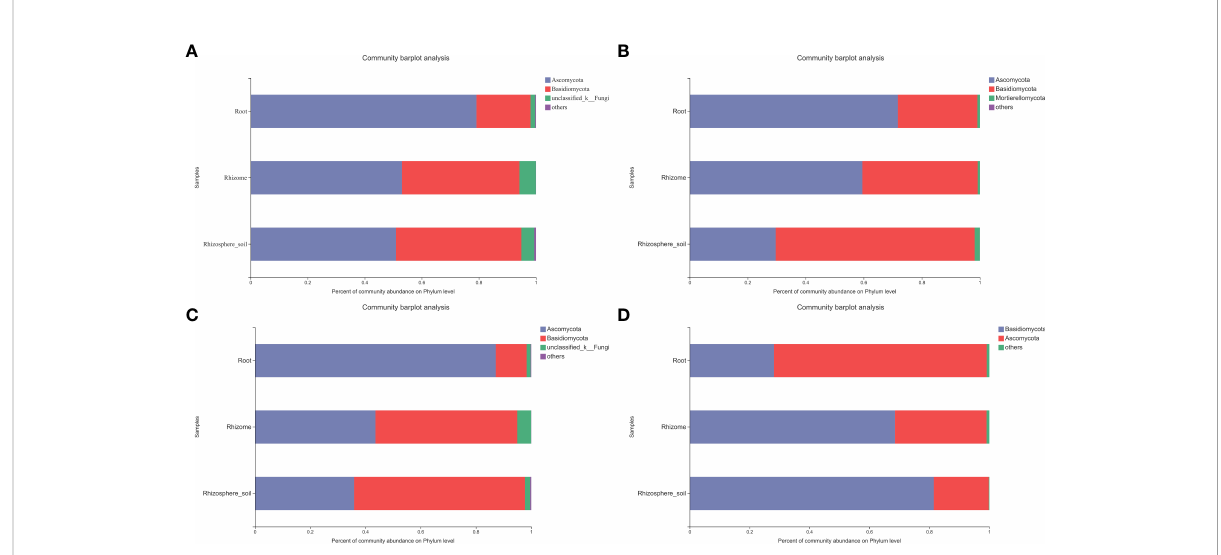
FIGURE 3 Bar diagram of fungal community composition. The ordinate is the sample name, and the abscissa is the proportion of species in the sample. Columns with different colors represent different species, and the length of the column represents the proportion of the species. (A) : fungi composition at Phylum level; (B) : mycorrhizal fungi composition at Phylum level; (C) : fungal composition of the middle of Tiankeng (Phylum); (D) : mycorrhizal fungi composition of the middle of Tiankeng